Question: Name the type of graph shown.
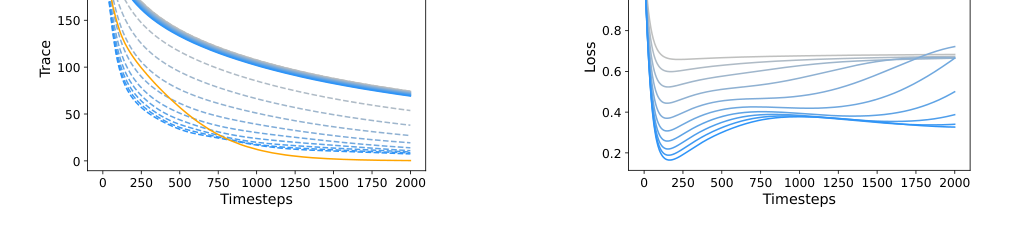
Answer: line